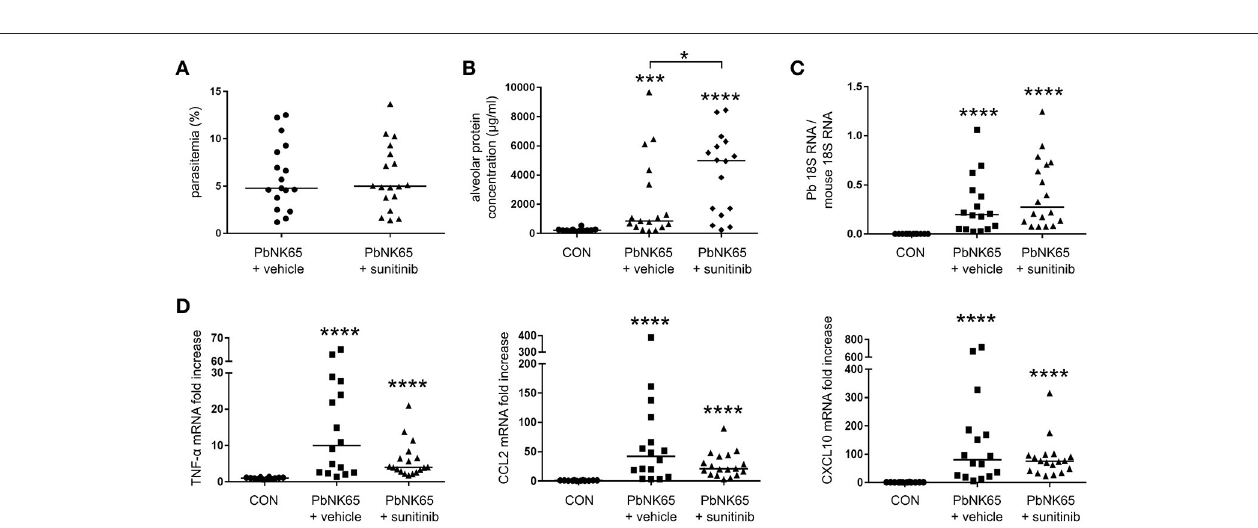
FIGURE 6 | Treatment of mice with sunitinib increases lung pathology in PbNK65-infected C57BL/6 mice. C57BL/6 mice were infected with PbNK65 and were treated by daily gavage from day 6 pi on with sunitinib or with vehicle. (A) Peripheral parasitemia was determined at day 8 pi and (B) alveolar edema was measured by protein determination of BALF samples. (C,D) The mRNA expression of P. berghei 18S, TNF- α , CCL2, and CXCL10 was analyzed by qRT-PCR. Compilation of three experiments, n = 12–18 per